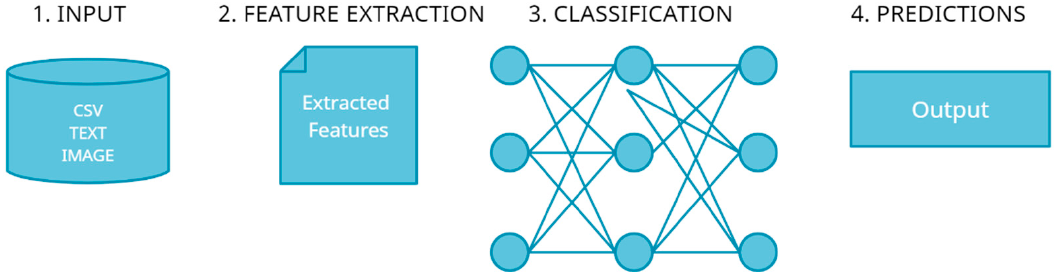
Figure 1. Basic steps involved in machine learning problems.